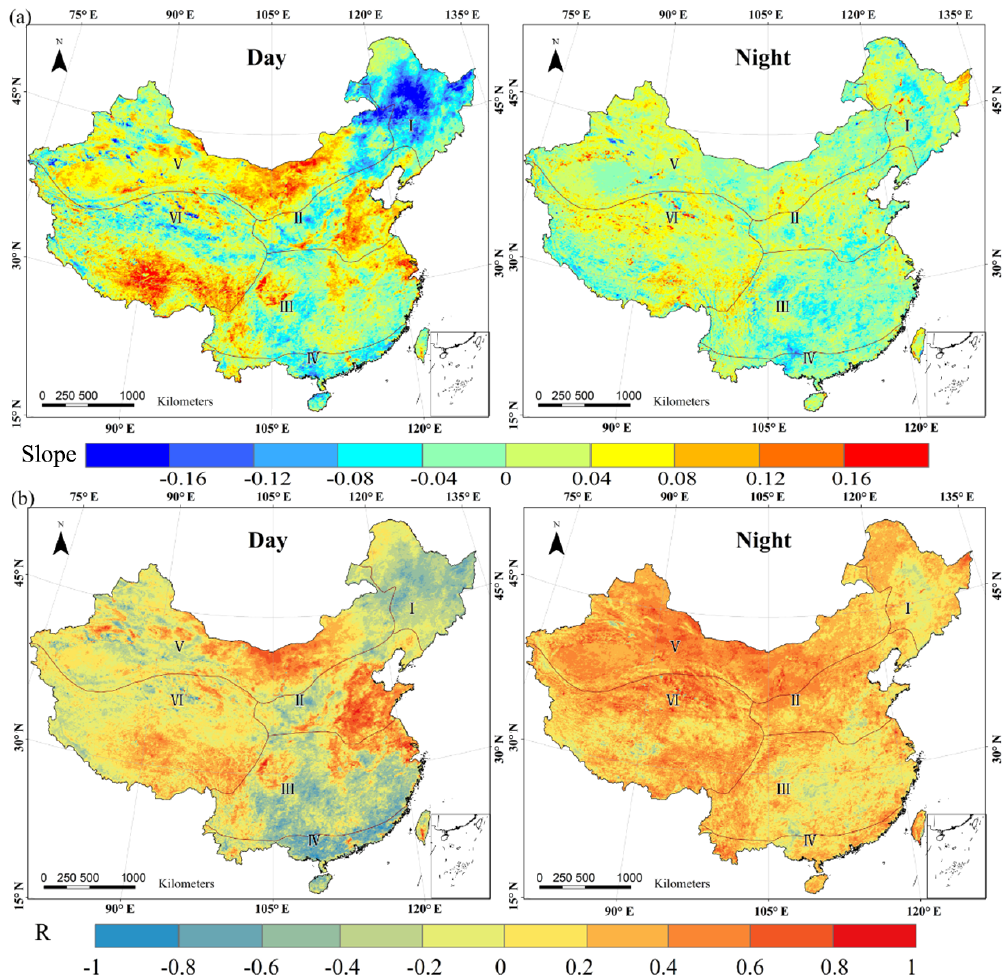
Figure A2. Spatial dynamics of day and night LST change trends based on (a) slope and (b) correlation coefficient.